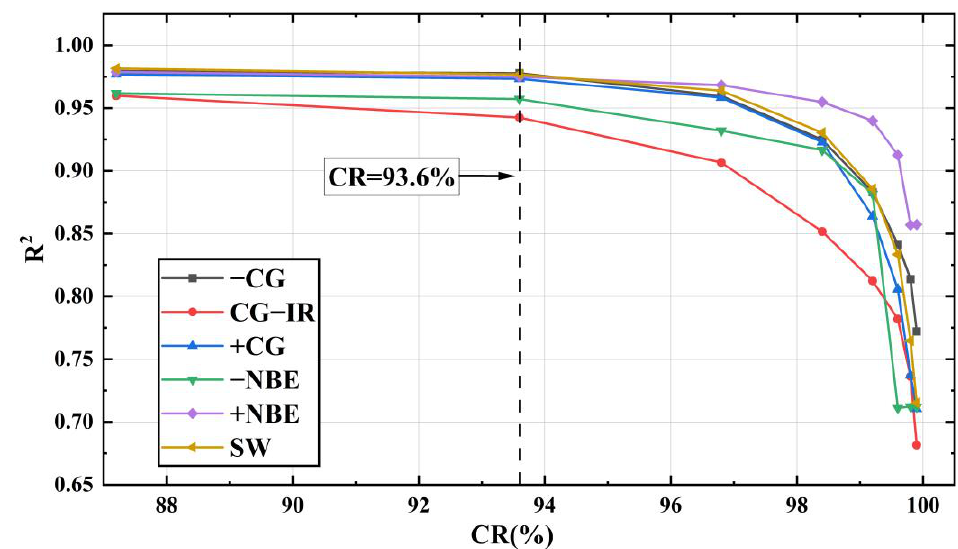
Figure 13. 𝑅 2 comparison chart of LEMP waveforms after LCSAE model training. Figure 13. R 2 comparison chart of LEMP waveforms after LCSAE model